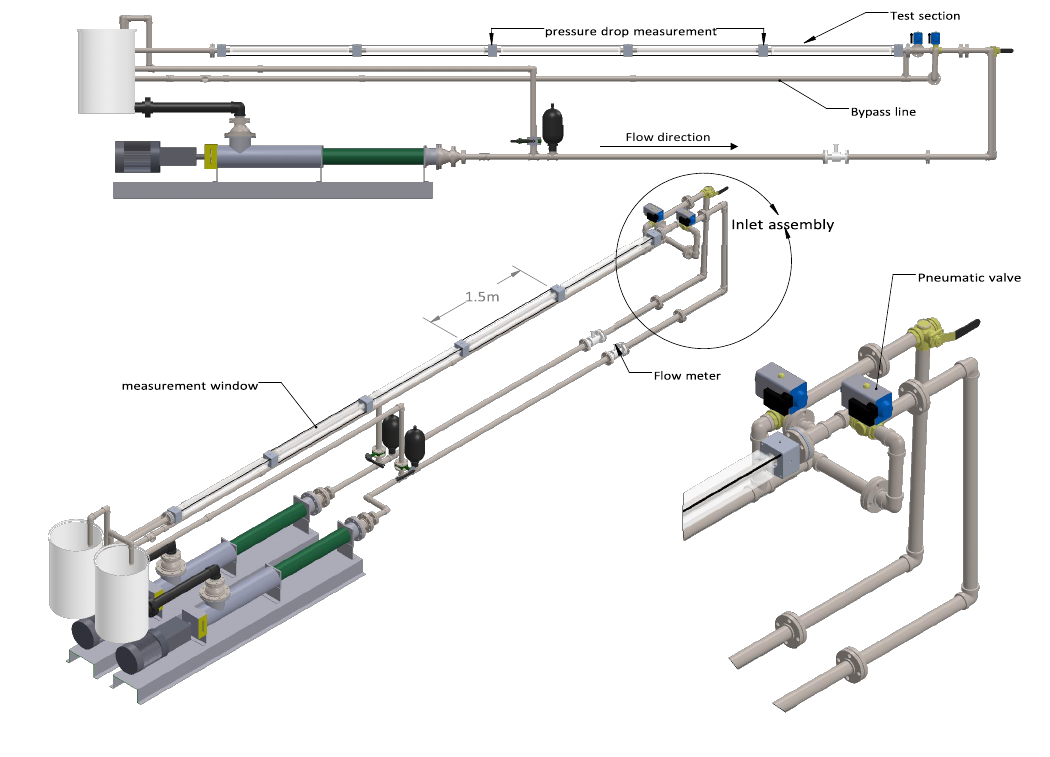
Figure 1. Schematic of the flow loop. Table 1. Dimensions of the flow